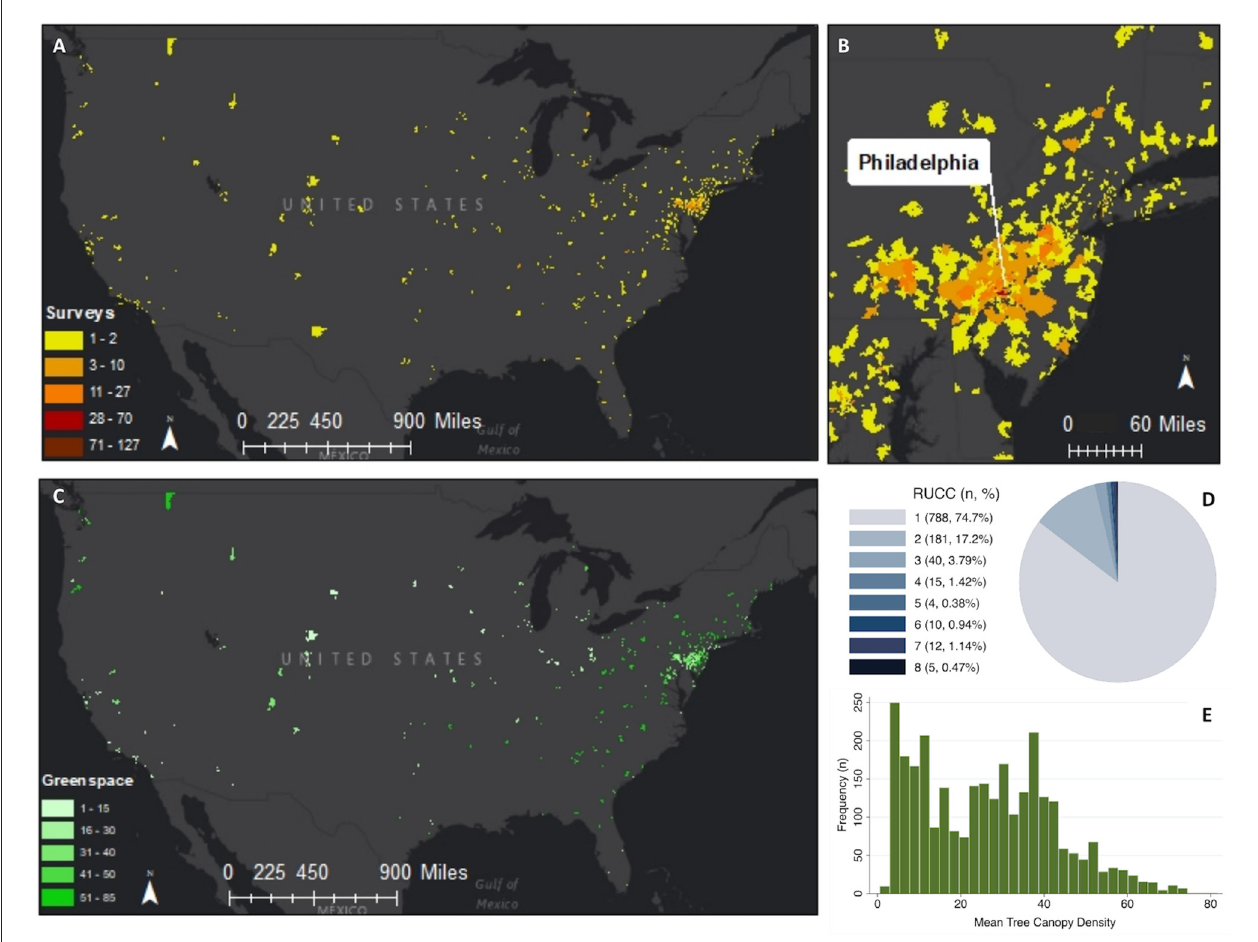
FIGURE 1 | Geospatial analysis of survey data and greenspace showing: (A) the distribution of the surveyed population across ZIP Codes throughout the United States; (B) a close-up of the surveyed population in the greater Philadelphia area; (C) estimated greenspace in all surveyed ZIP Codes. Note ZIP Codes with 0% green space do not appear on the map; (D) The distribution of urbanicity measured by Rural-Urban Continuum Codes (RUCC) for all surveyed ZIP Codes ranked 1 (most urban) to 8 (most rural); (E) The distribution of greenspace in the surveyed population. Base-map Credits: Esri.